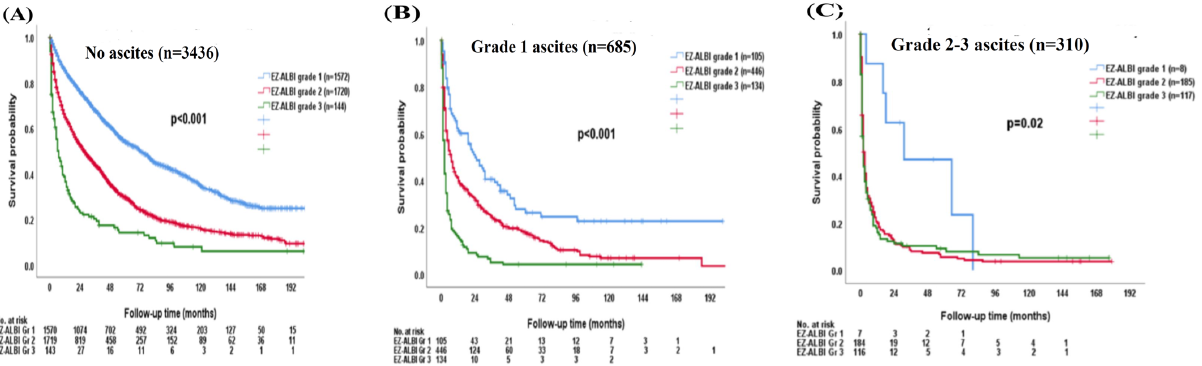
Figure 5. The survival distribution of different EZ-ALBI grades according to patients ( A ) without ascites, ( B ) grade 1 ascites, ( C ) grade 2–3 ascites. The EZ-ALBI grade can discriminate overall survival in patients without ascites ( p < 0.001), grade 1 ascites ( p < 0.001), and grade 2–3 ascites ( p = 0.02).